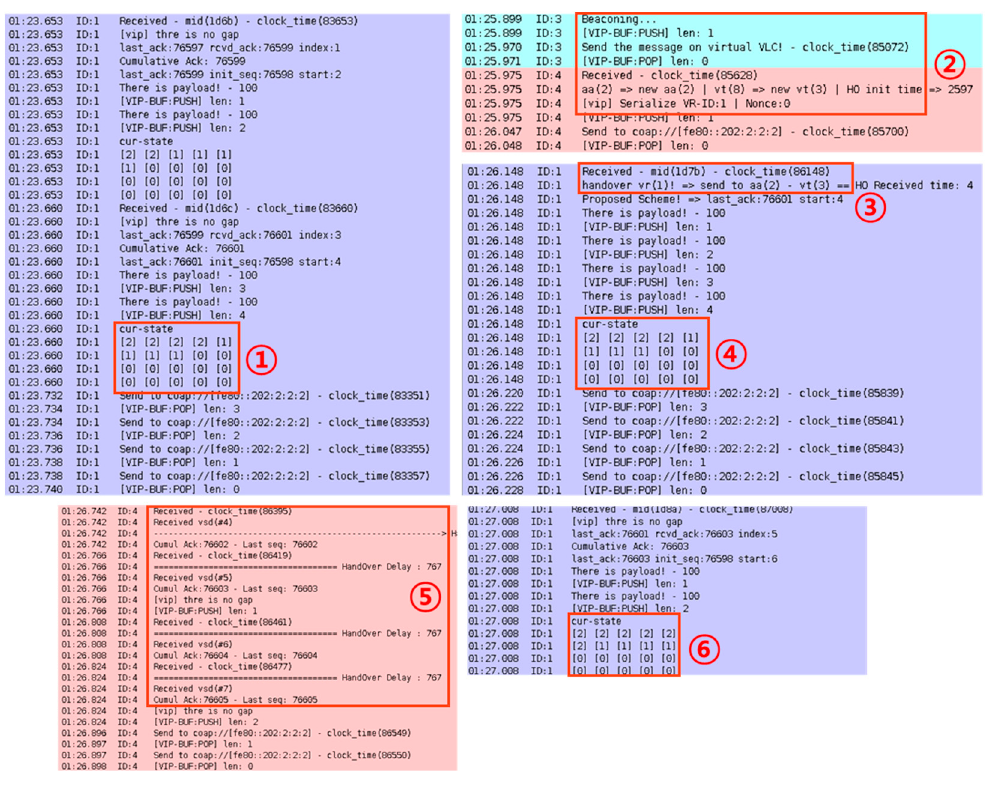
Figure 21. Packet analysis for the VT handover.